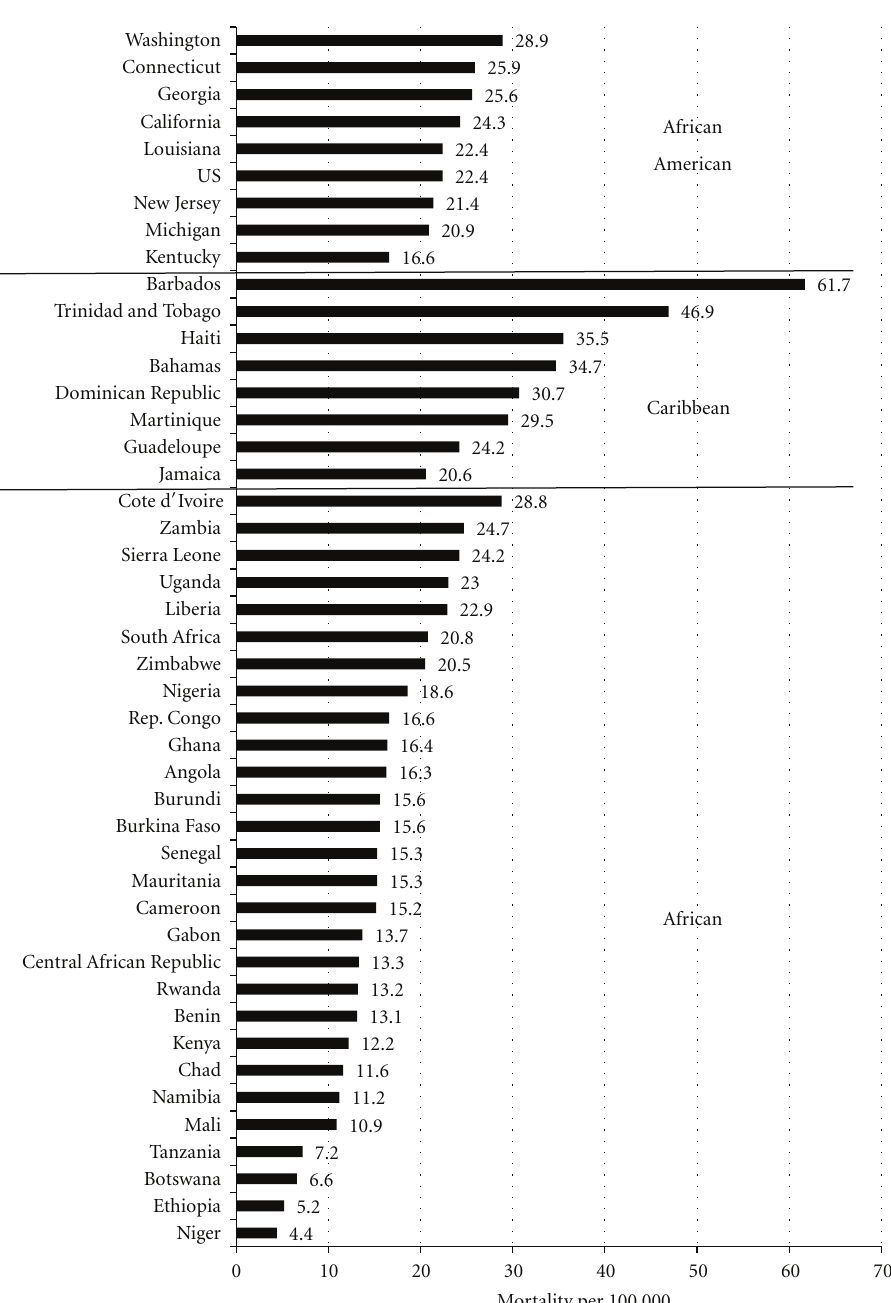
Figure 2: Estimates of 2008 CaP mortality per 100,000 men, age-standardized to the 1960 world population. African American data are from states with at least one SEER-17 cancer registry (excluding states with fewer than 10 CaP deaths), African and Caribbean data are from GLOBOCAN